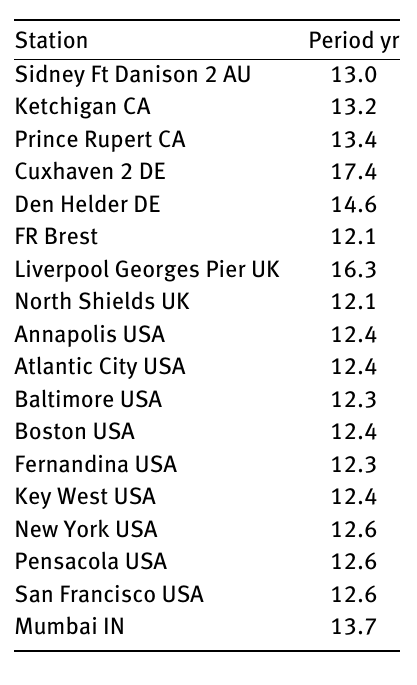
Table 2: Statistically significant ( p <0.05) decadal periods in years (Iz, 2015).